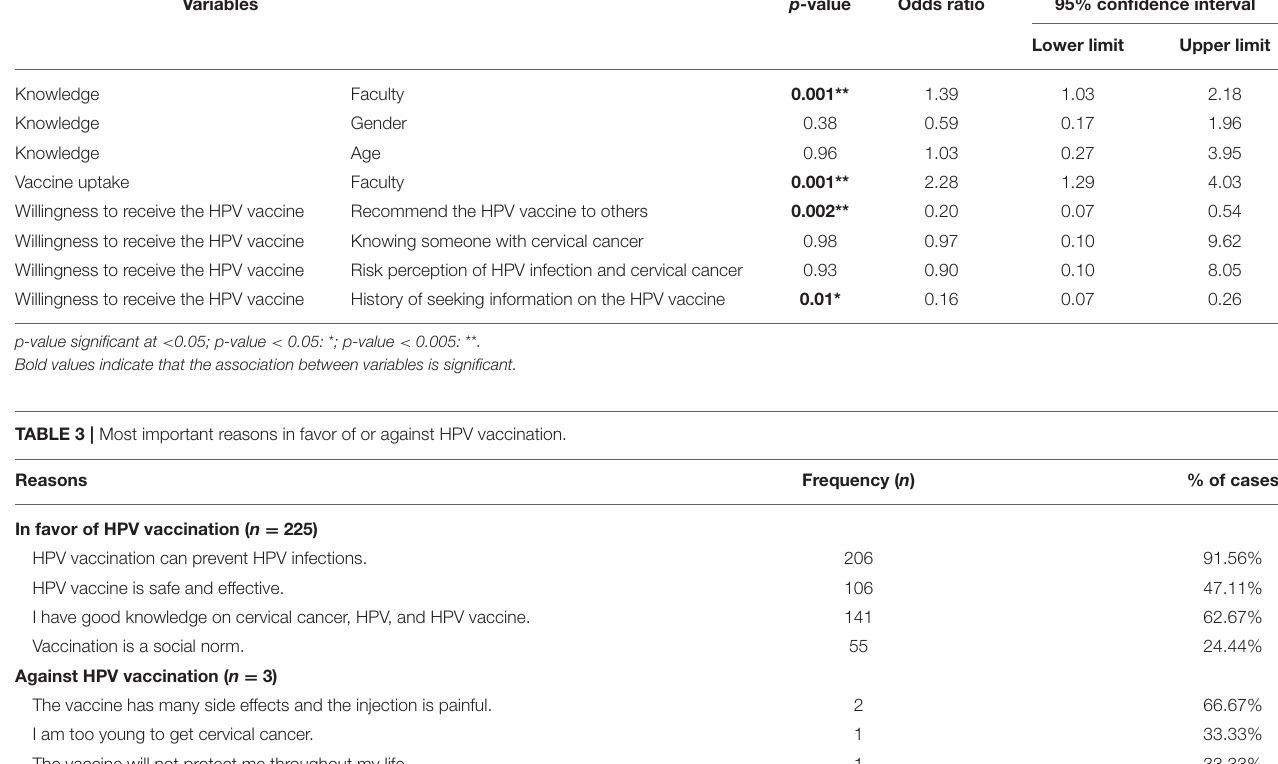
TABLE 2 | Computation of association between different variables. Variables